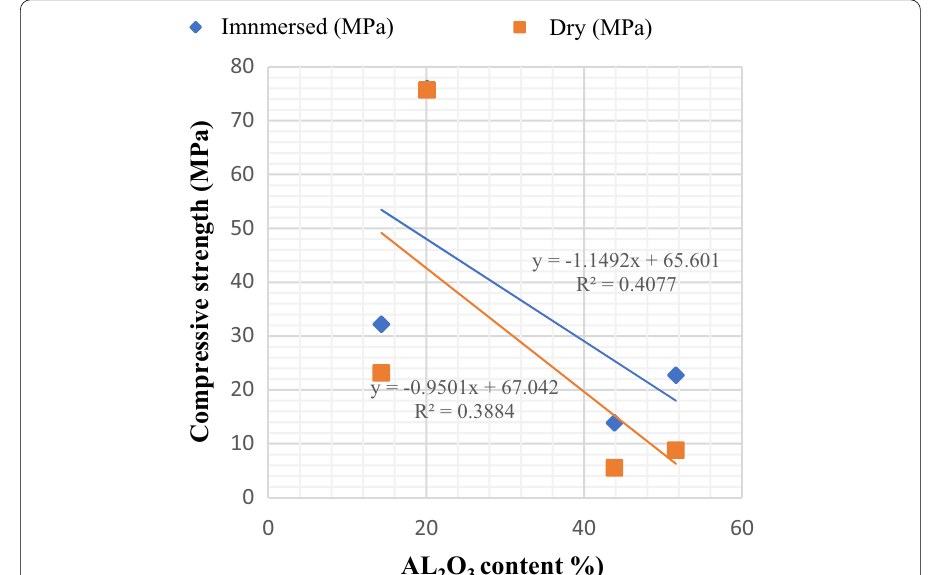
Fig. 10 Influence of Al 2 O 3 content on dry and immersed compressive strength